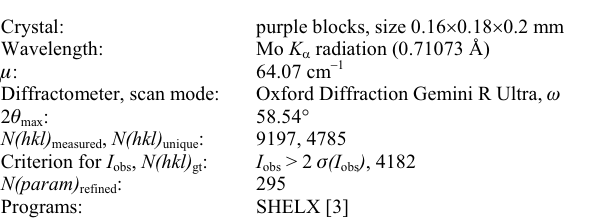
Table 1. Data collection and handling.